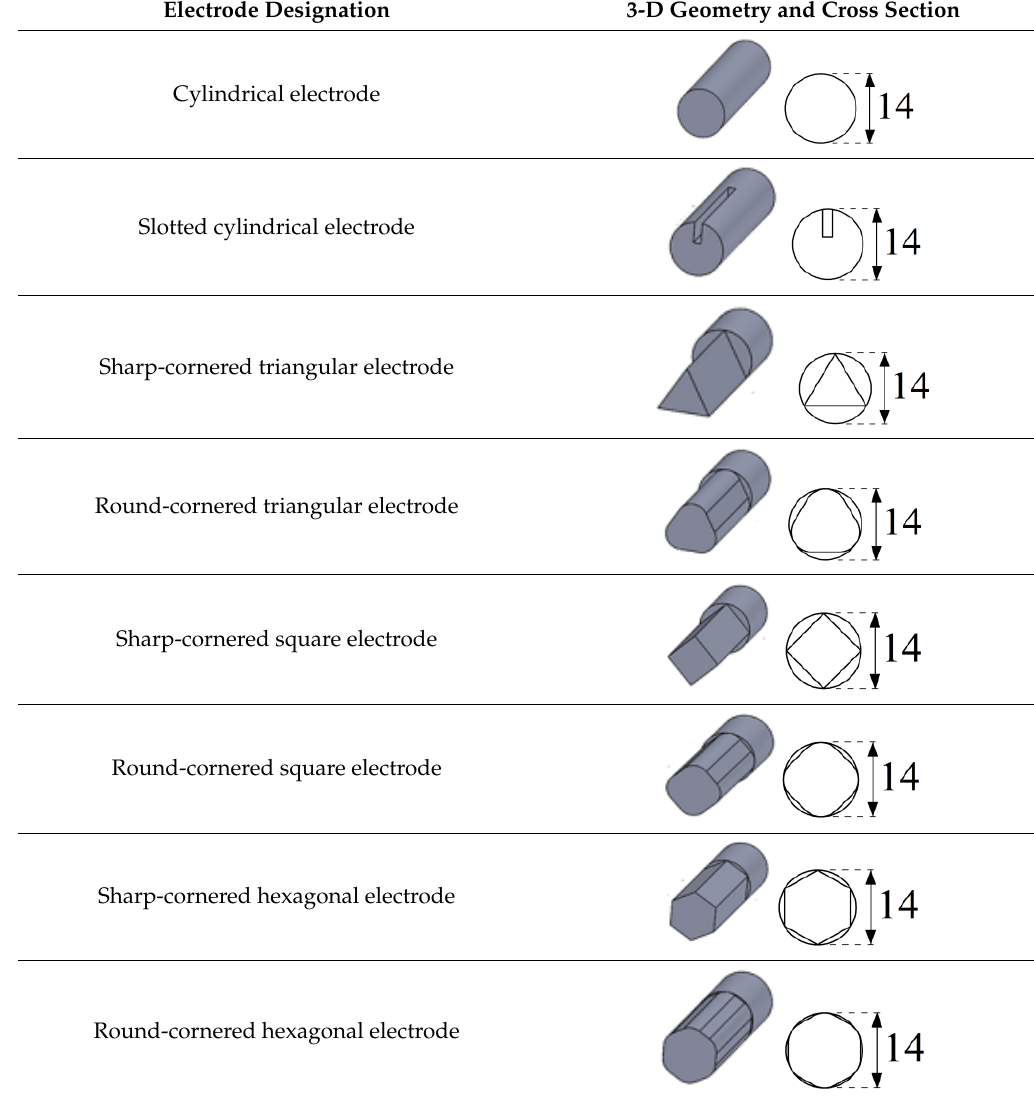
Table 4. The electrode designation, 3-D representation and cross section.